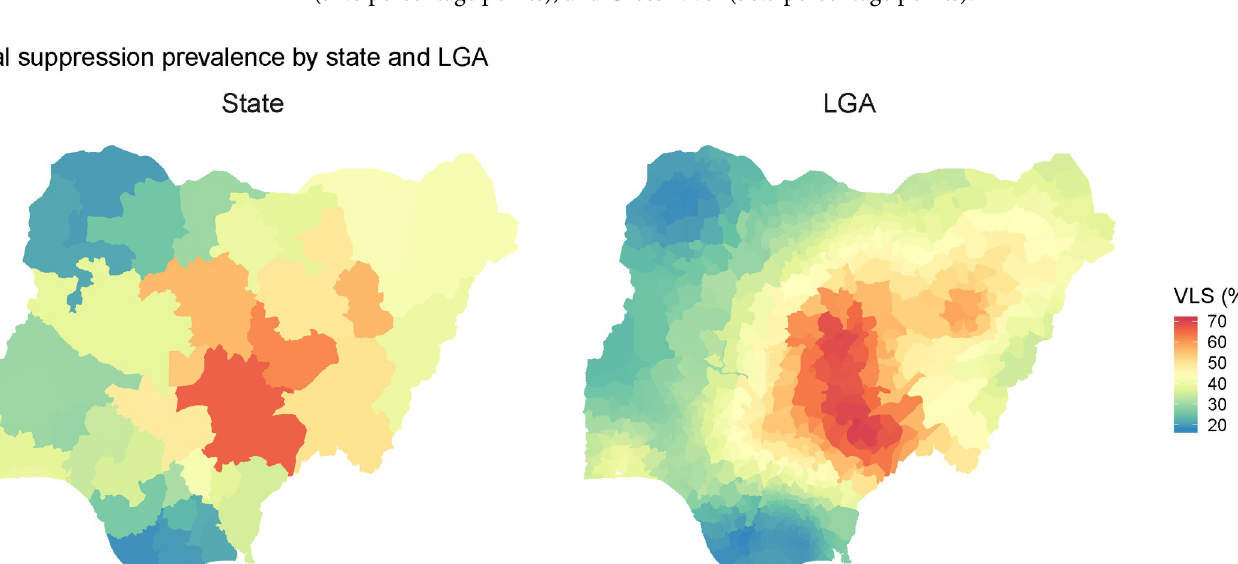
PLOS ONE | https://doi.org/10.1371/journal.pone.0268892 June 8,